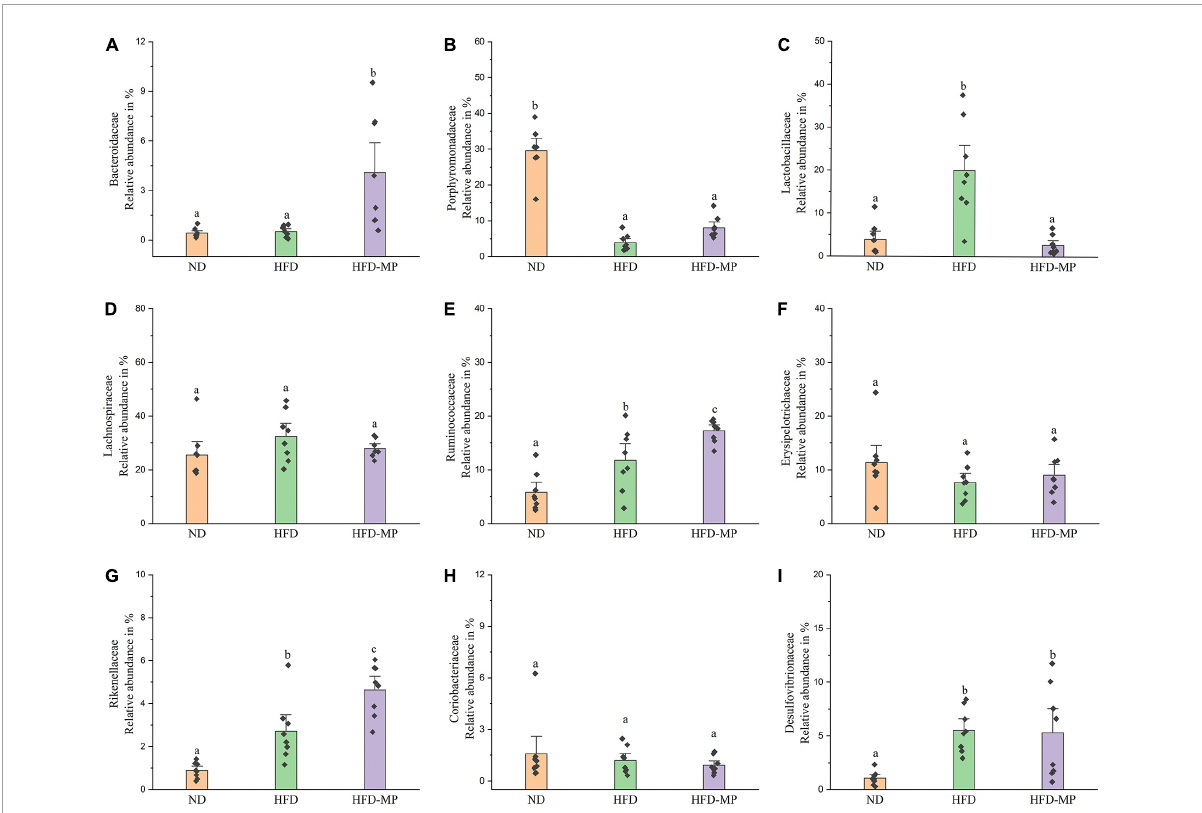
FIGURE6 The comparative analysis of nine main families of the gut microbiota, including (A) Bacteroidaceae, (B) Porphyromonadaceae, (C) Lactobacillaceae, (D) Lachnospiraceae, (E) Ruminococcaceae, (F) Erysipelotrichaceae, (G) Rikenellaceae, (H) Coriobacteriaceae, and (I) Desulfovibrionaceae. The data are represented as the mean ± SEM. Statistical differences were carried out by one-way ANOVA followed by Tukey’s test, p < 0.05 indicates significant differences.